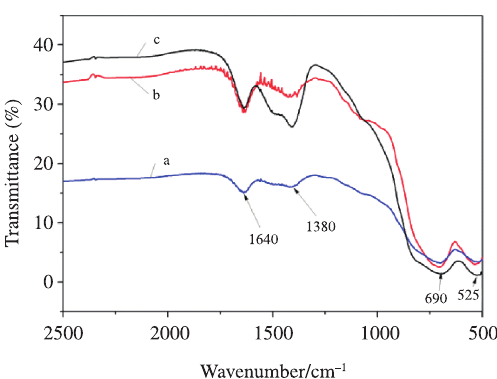
Figure 6. FT-IR spectra of MgAl 900 °C for 2h (a. SPAN-80 + Triton X-100, forward-titration; b. SPAN-80 + Triton X-100, reverse-titration;c. NP-40, forward-